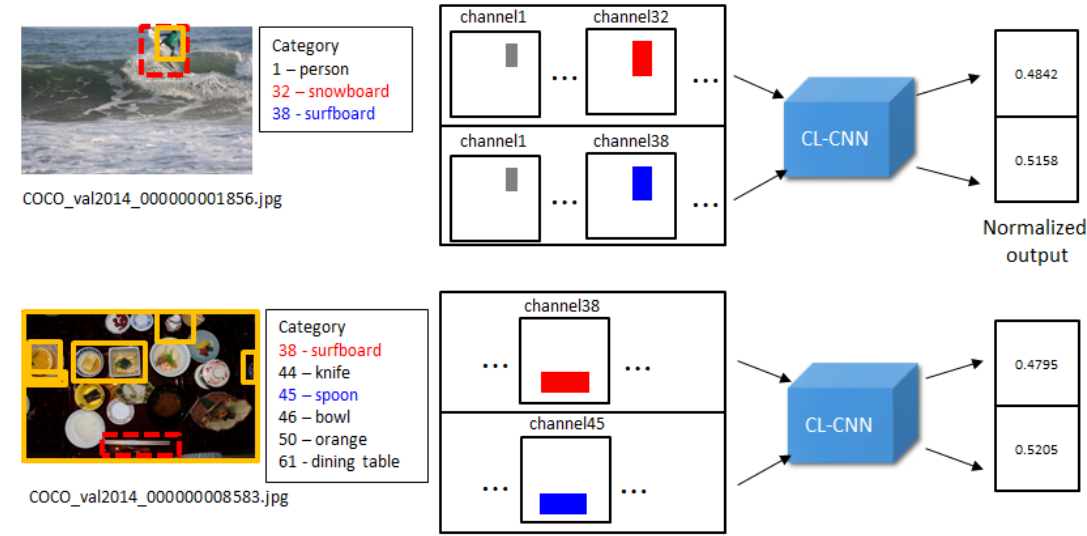
Figure 9. The encoded inputs from the detected objects by the R-CNN are processed through the CL-CNN. Each object from the output is respectively excluded as explained in Equations (4) and (5) to evaluate the contextual